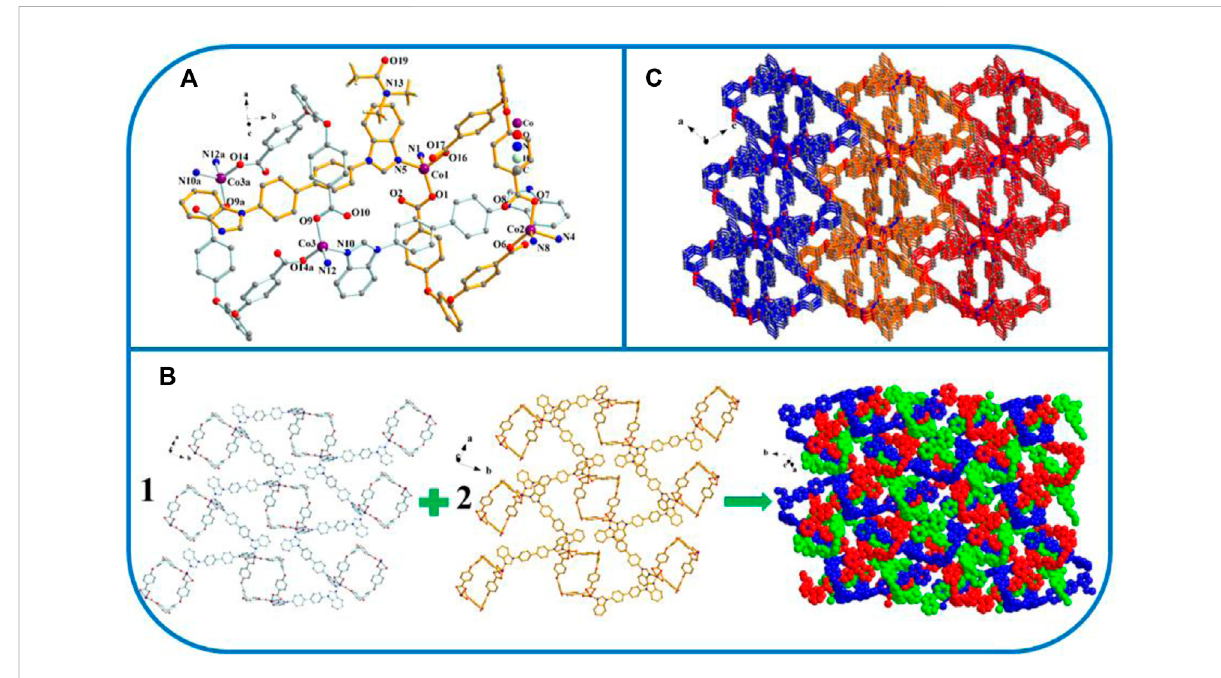
FIGURE 2 (A) Coordination environmentof the Co ion inYMUN2 ((hydrogen atoms are omitted for clarity),symmetrycodes: (i) - x +5/2, y +1/2,- z +5/2;(ii) - x +3/2, y +1/2, - z +3/2; (iii) - x +1, - y +2, - z +1; (iv) x -1/2, - y +3/2, z -1/2; (v) - x +5/2, y -1/2, - z +5/2; (vi) - x +3/2, y -1/2, - z +3/2; (vii) x +1/2, - y +3/2, z +1/2.); (B) view of the three-fold interpenetrating 2D strati fi ed network through the different 2D lamellar structures of 2; (C) view of the 3D framework through the 2D strati fi ed network with weak interactions occurring along the b